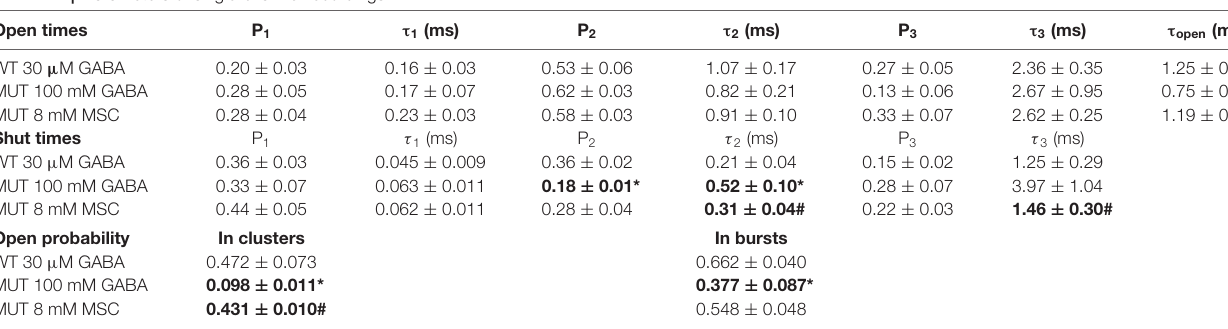
TABLE 1 | Parameters of single-channel